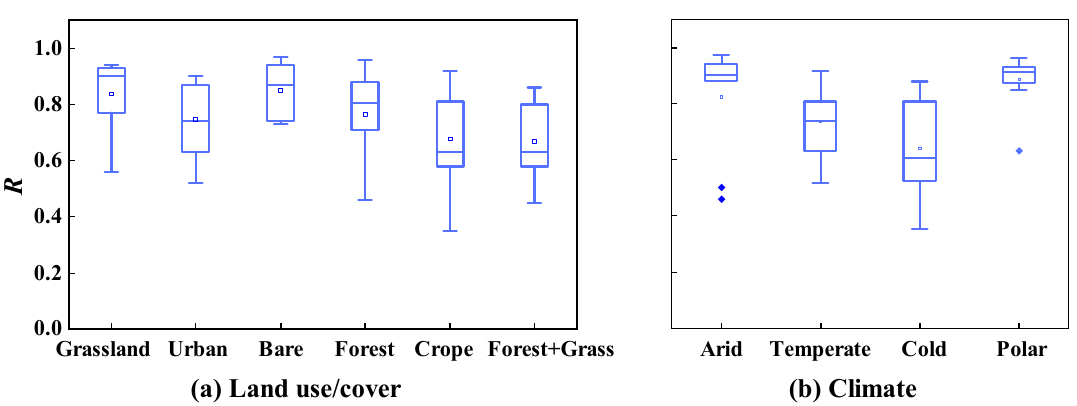
Figure 12. Box plots of R for the influencing factors: ( a ) land use/cover (LULC) types and ( b ) climate types for the 79 stations.